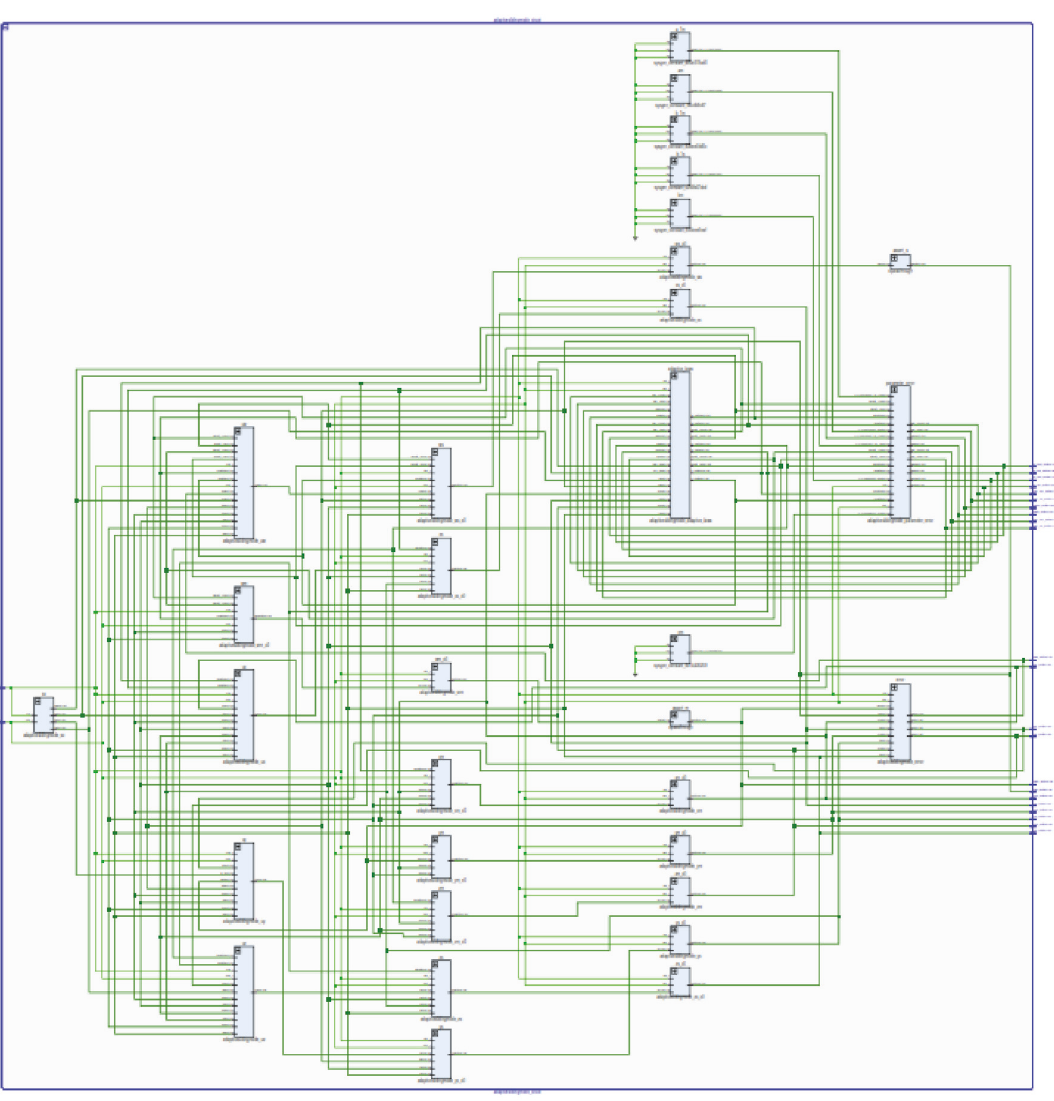
Figure 15: Xilinx RTL schematics of the FOASMC controllers implemented in Virtex